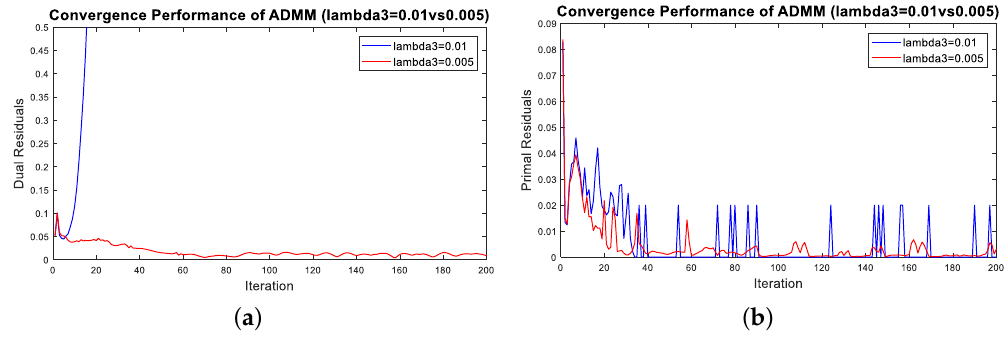
Figure 5. Convergence of primal residuals and dual residuals with different regularization parameters: ( a ) primal residuals of λ 3 = 0.01 vs. λ 3 = 0.005; and ( b ) dual residuals of λ 3 = 0.01 vs. λ 3 =